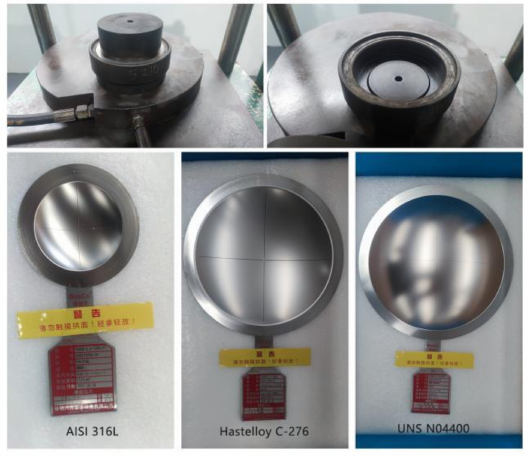
Figure 5. Forming mould base and rupture discs of different